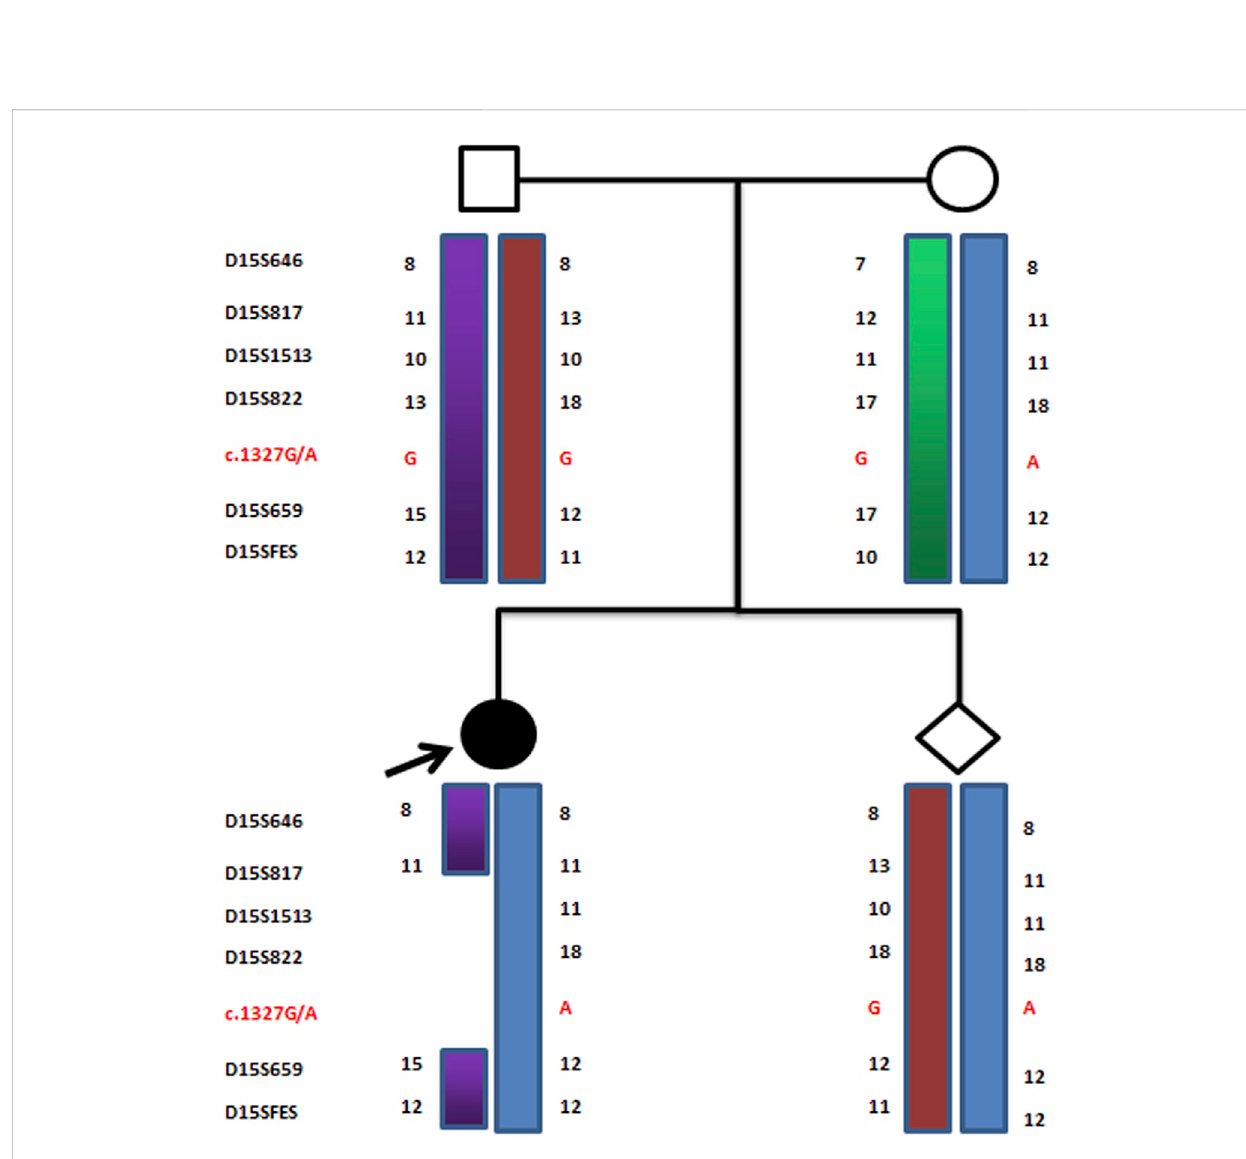
FIGURE 6 Photograph of proband 1 at 13 months. She was diagnosed as OCA2 with